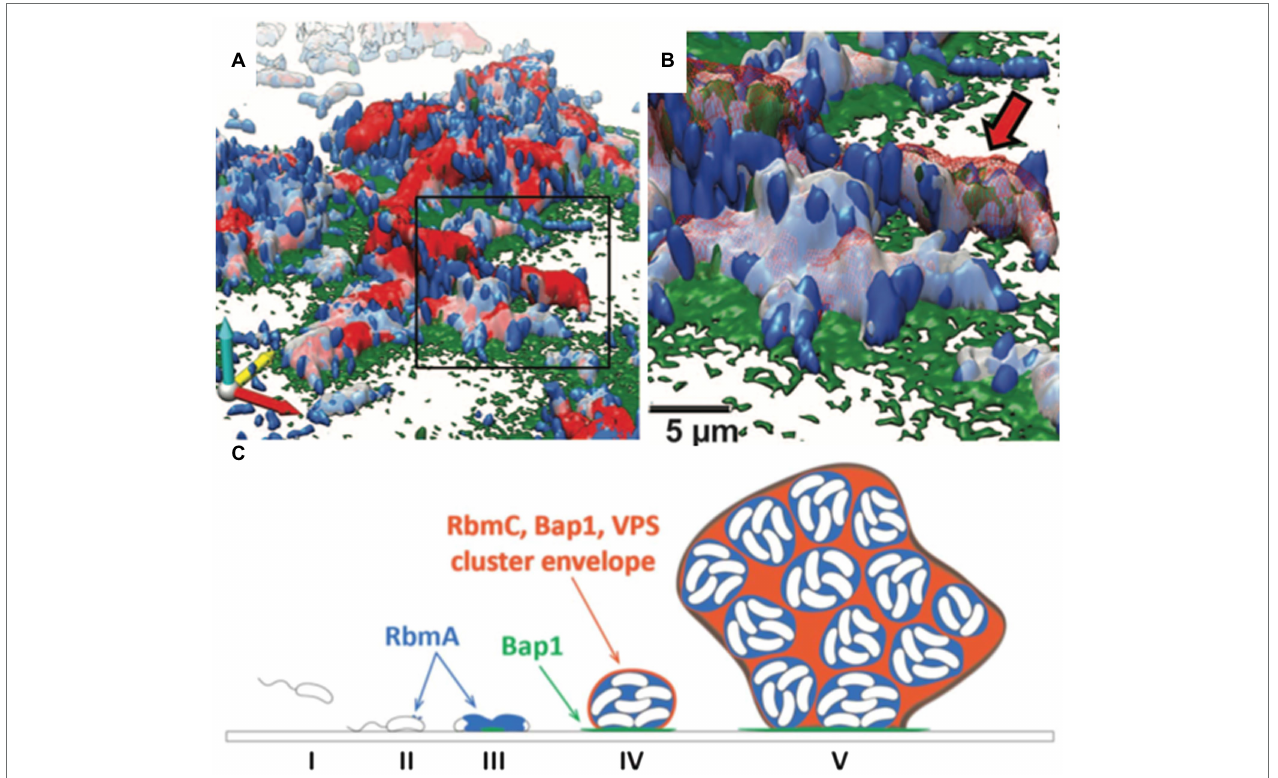
FIGURE 4 | The V. cholerae biofilm structure. (A) Three-dimensional architecture of a V. cholerae biofilm obtained through high-resolution SCLM. Images are pseudocolored in blue (cells), gray (RbmA), red (RbmC), and green (Bap1). RbmA localizes around and within the cell cluster, whereas Bap1 and RbmC encase the cell clusters. The Bap1 signal is also concentrated at the biofilm-substratum interface. (B) Enlargement of the box region in (A) . The red arrow indicates one cell cluster. (C) Proposed model of biofilm development in V. cholerae . This figure is adapted with permission from Berk et al.